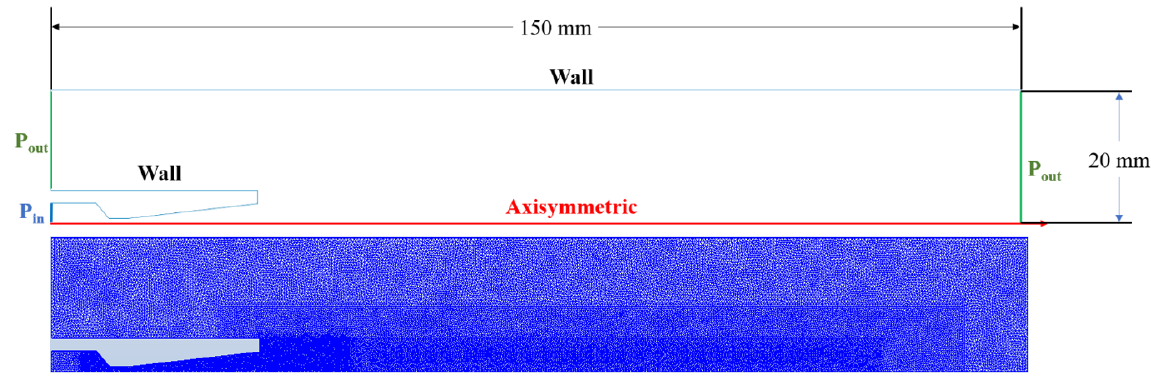
Figure 5. Geometry and mesh structure for cavitation nozzle. Domain size: 150 cm × 20 cm.